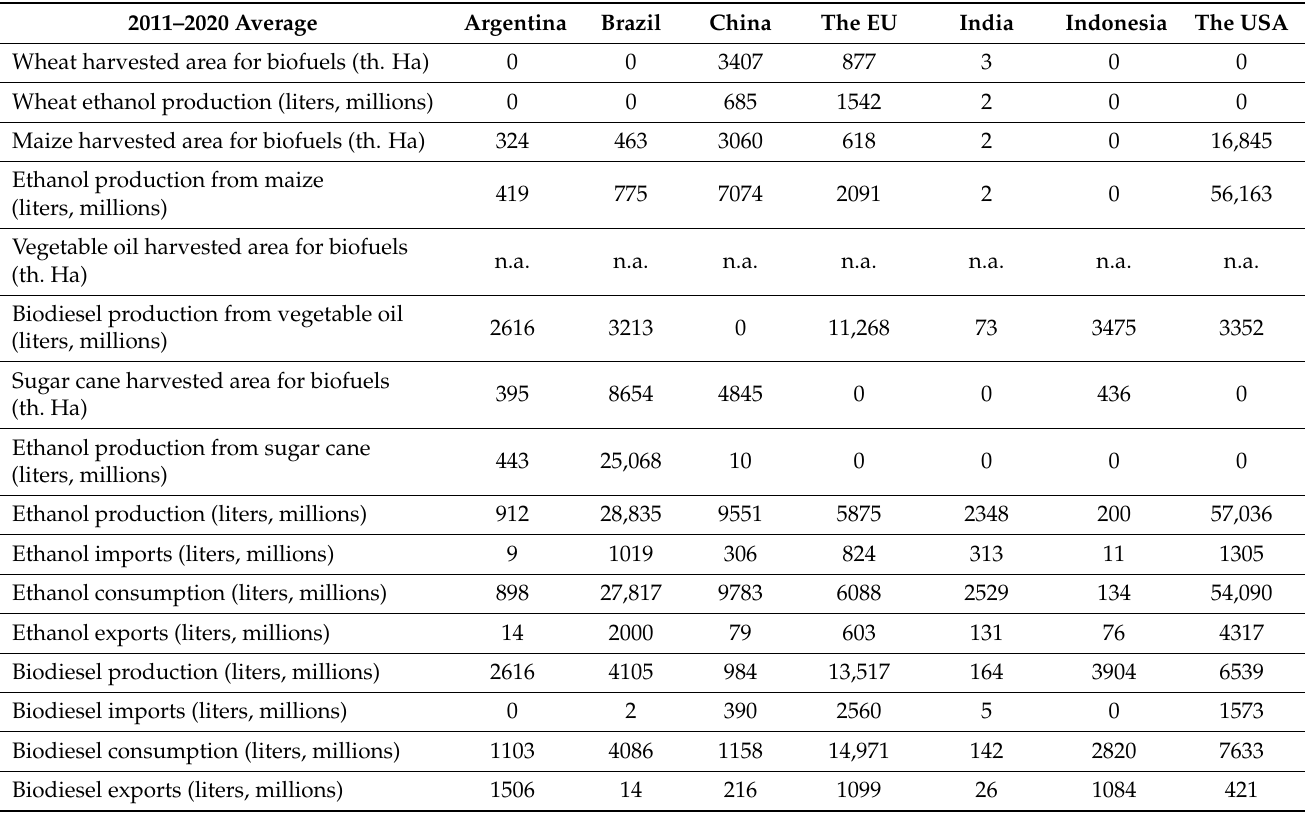
Table 2. Largest biofuel-producing countries in aspects of harvested area, production, and export- import activity between 2011 and